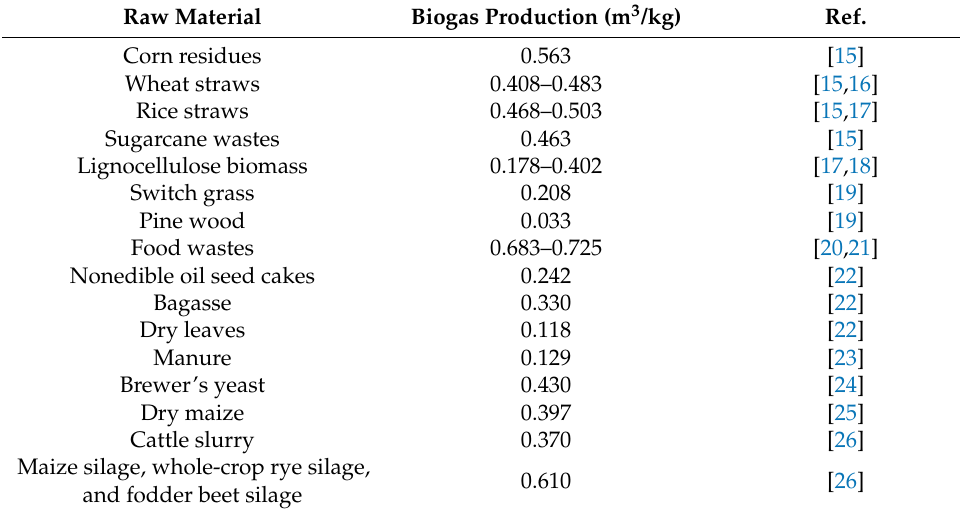
Table 2. Amount of biogas produced from one kilogram of